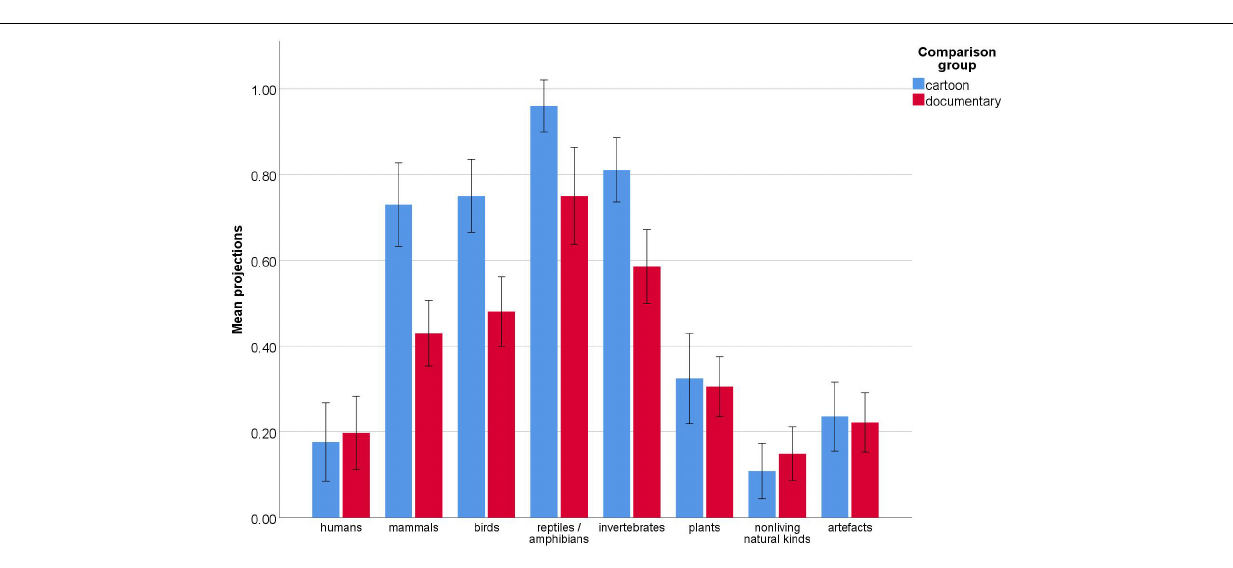
than to the remaining categories but no other difference was statistically significant. All tests were two-tailed with a significance level of